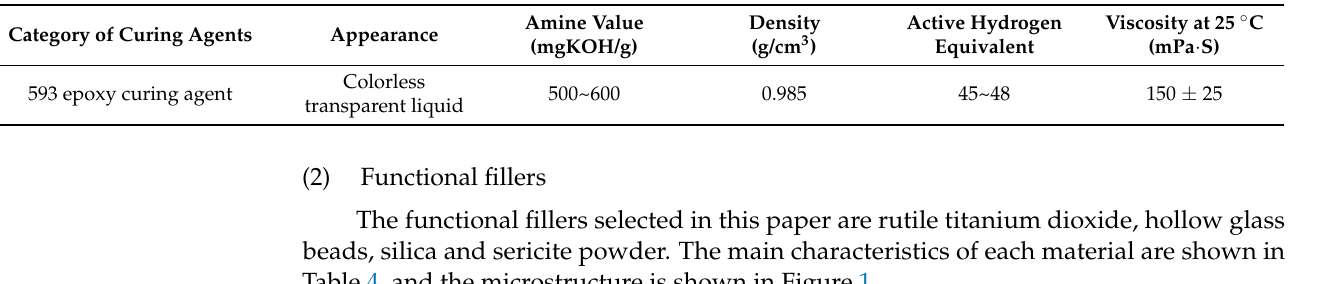
Table 2. Material properties of 593 curing